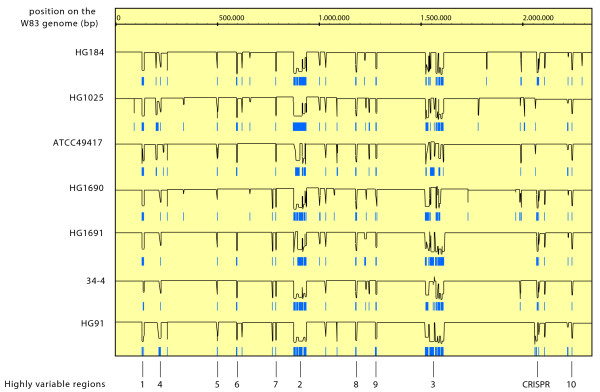
Highly variable regions of P. gingivalis. Breakpoint analysis of test strains describing potential lacking genomic regions as positioned on the W83 genome sequence. Black lines depict breakpoint data. As long as the line is flat there is low variability of the test strain compared to W83. Dips in the line indicate variability. Blue lines/rectangles below depict potential absent regions. At the top the probe positions are given as described in the W83 genome [29]. The numbers at the bottom label the 10 highly variable regions in each strain which are explained in the text. CRISPR represents a region of interest with CRISPR associated genes as described in the text.